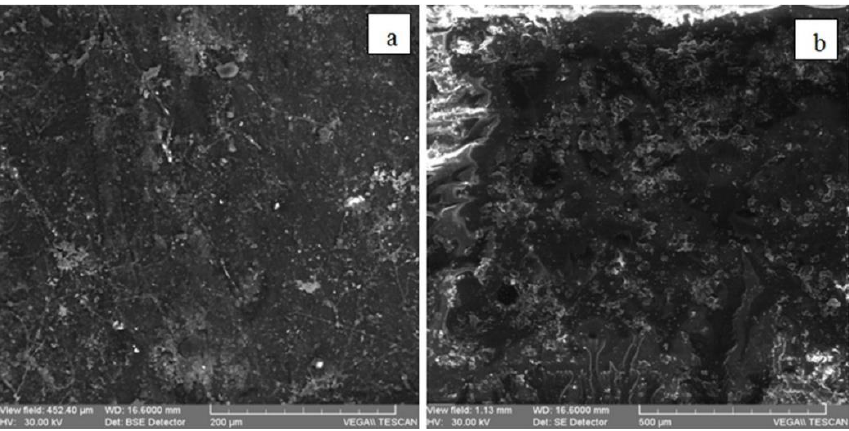
Figure 8. SEM microphotographs: ( a ) new varnish; ( b ) old varnish.